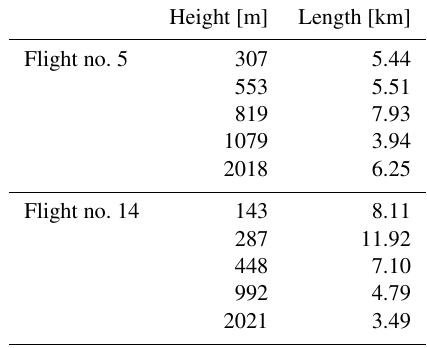
Table 1. Mean altitude and length of the LEGs.